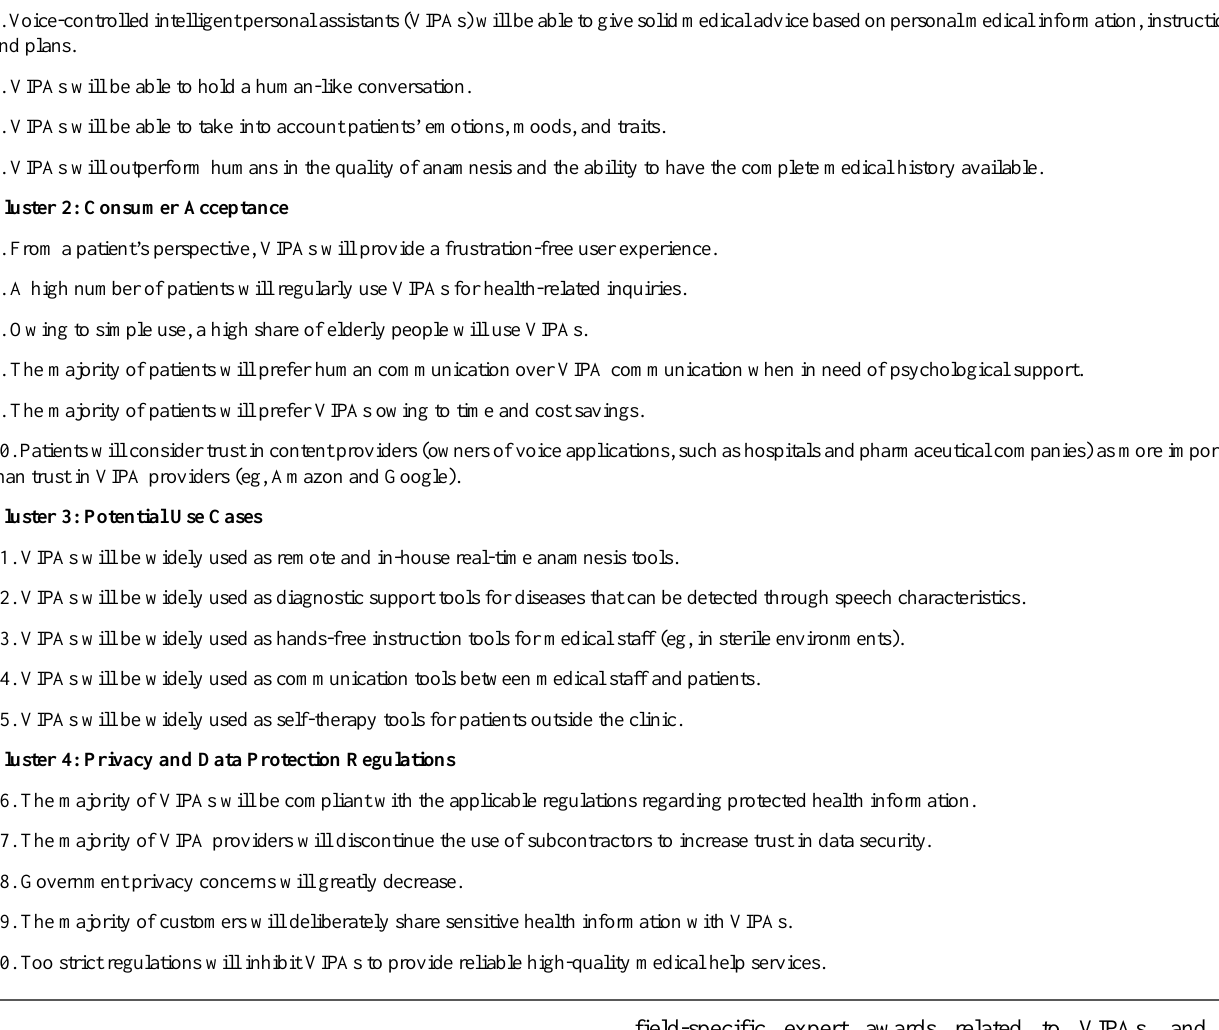
field-specific expert awards related to VIPAs, and job descriptions or posts on the professional social